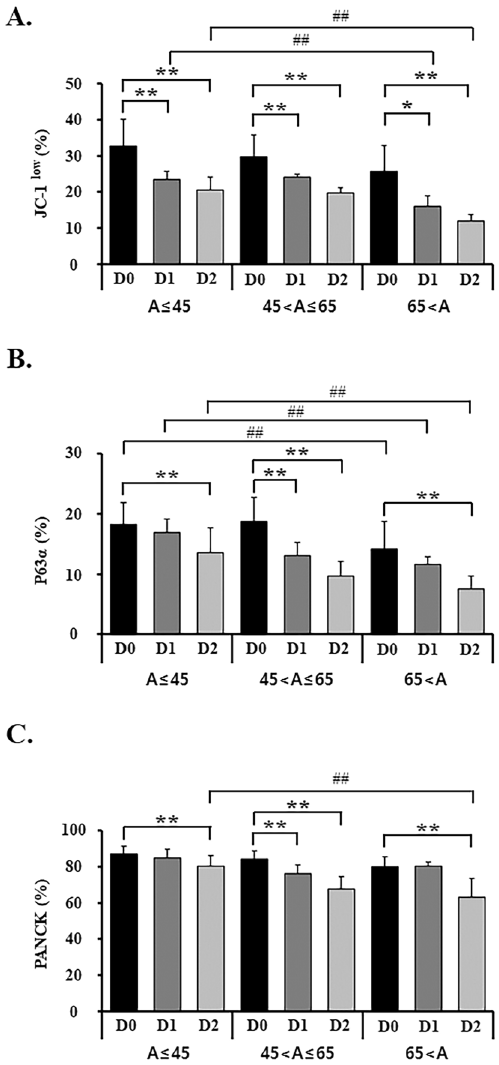
Figure 5. Preservation effects of stem/precursor properties of limbal epithelial outgrowth sheets from different donor’s ages on the storage period. ( A ) Percent of JC-1 low cells from FACS analysis and relationship with donor age are shown. JC1 dye exclusion reflects ABCG2 activity and result in the JC1 low cohort. ( B , C ) p63α and PANCK positive cells from FACS analysis are shown. *p < 0.05, **p < 0.01 (vs. D0, storage period), ## p < 0.01 (vs. 65 < A, age), n = 6 from 3